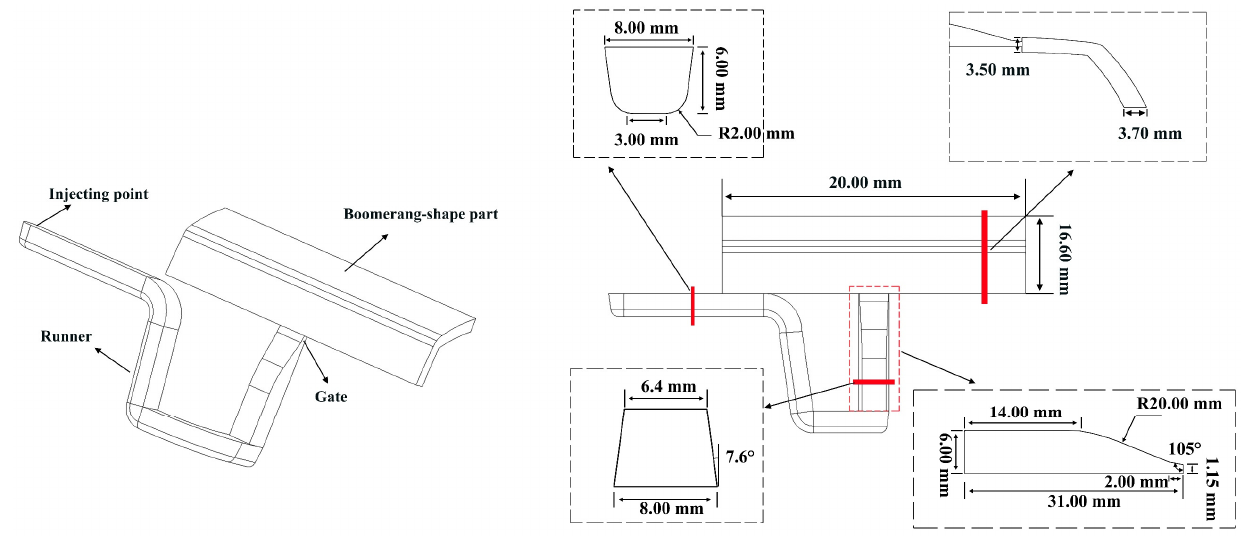
Figure 1. Geometry and the dimensions of the plastic part without insert close the gate.